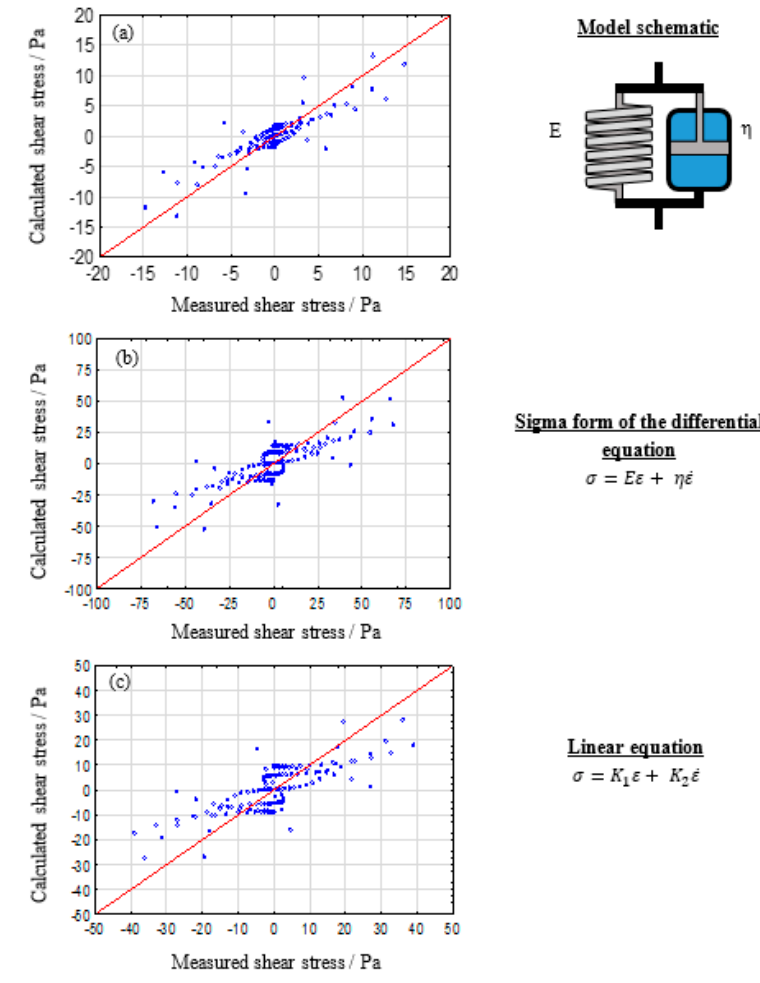
Figure 3. Evaluation of the Kelvin–Voigt model as suitable model to describe the viscoelastic properties of 2% ( a ), 5% ( b ), and 8% ( c ) alginate solutions.